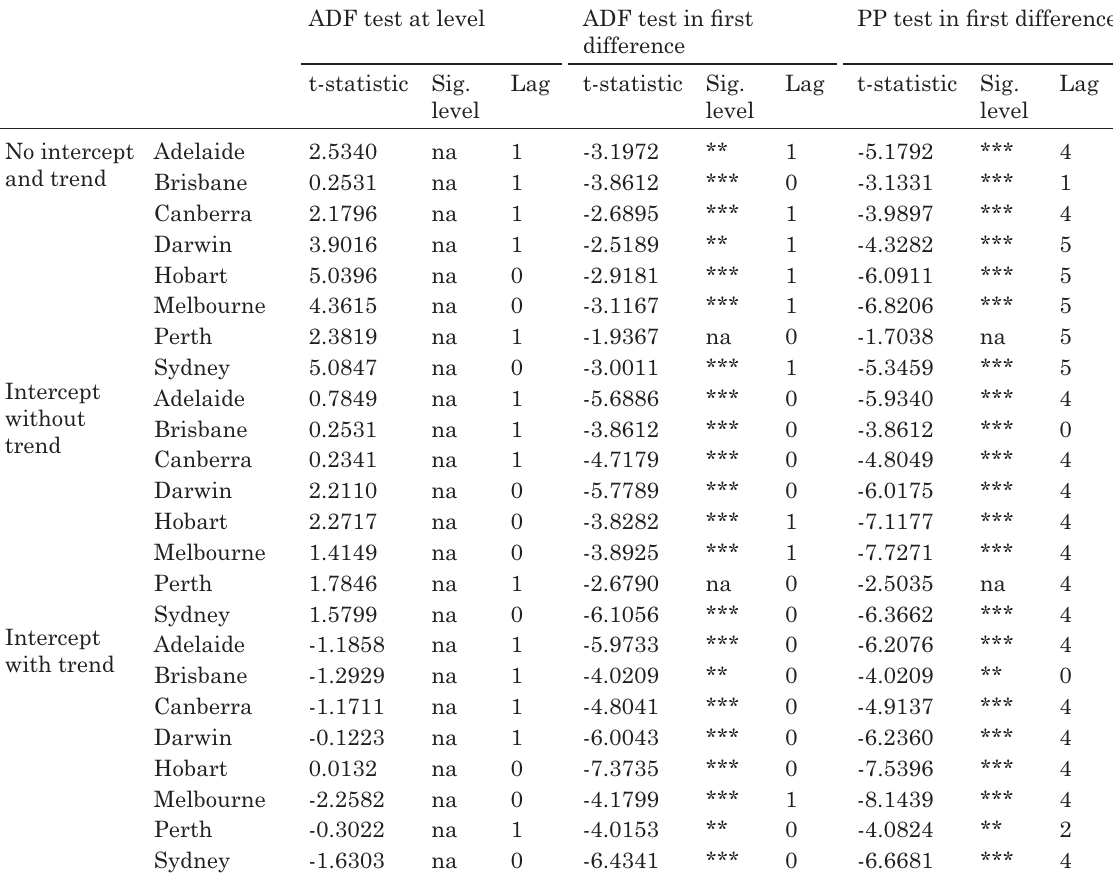
Table 1. Eight capital cities’ house price index series unit root tests from 1989 Q4 to 2007